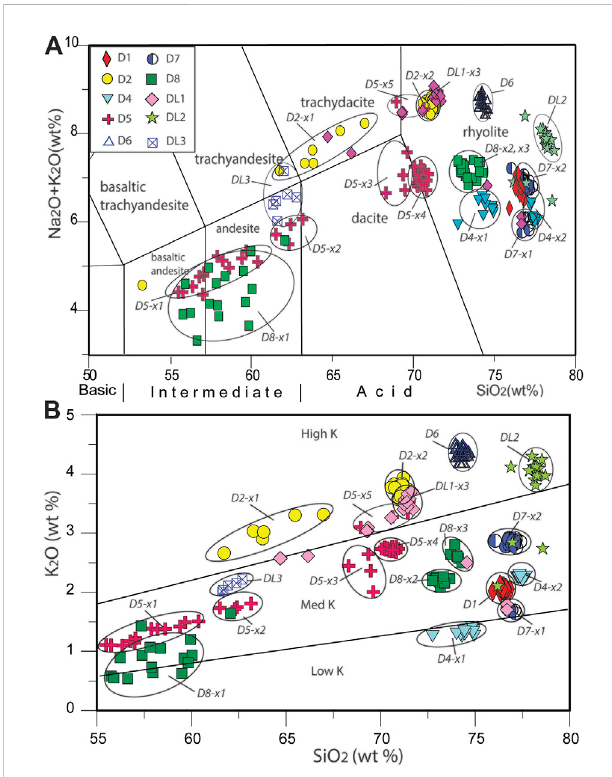
FIGURE 5 Classi fi cation diagrams for the glass from tephra layers found in core Lv63-4-2. (A) Classi fi cation TAS diagrams. Compositional fi elds according to Igneous Rocks and Le Maitre, (2002). (B) SiO 2 -K 2 O classi fi cation diagrams. Boundaries of high, moderate, and low-K rocks according to Gill (1981). The ovals highlight distinct glass populations, where average values are given in the Table 2; Supplementary Table S1. Different glass populations in heterogeneous tephra are shown with indices (x1, x2,